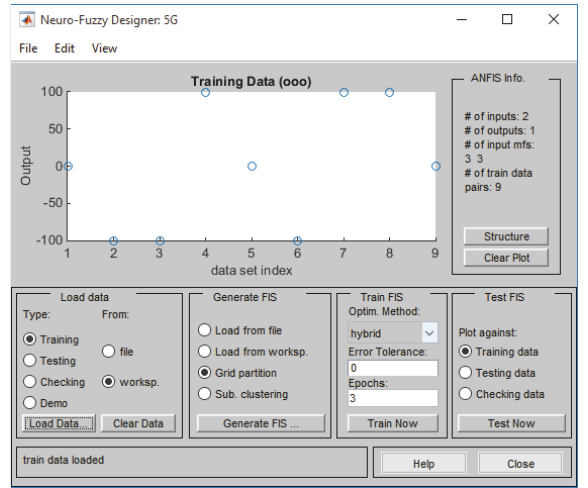
Figure 11: Training data. Nine desired output values and corre- sponding input values were specified as an array. The x-axis shows number of the array’s row. The y-axis shows desired output value.